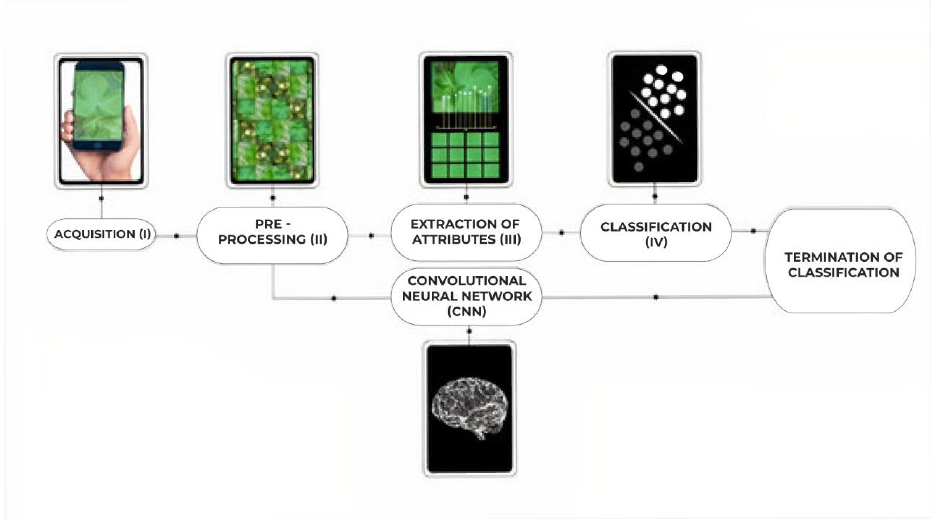
Figure 2. Pipeline adopted. In this paper, Steps III and IV were replaced by deep learning models.